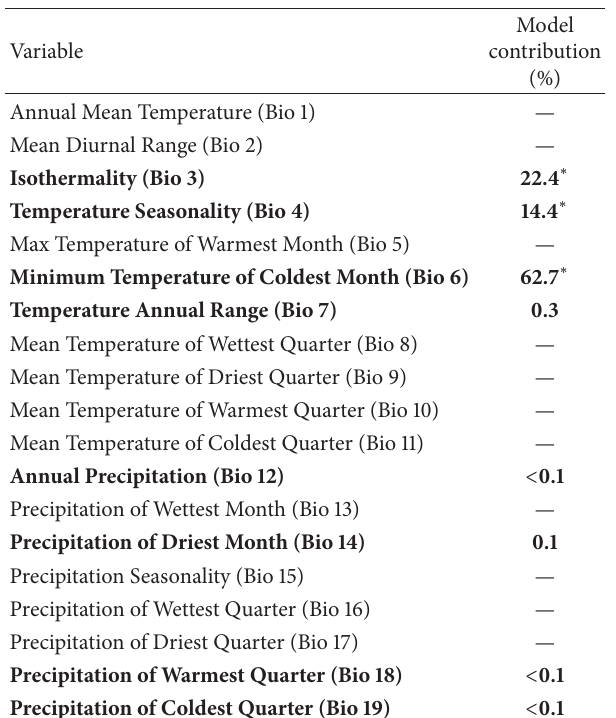
Table 1: Bioclimatic variables from WorldClim database. The variables in bold type were chosen to model the distribution of P. splendens after Pearson correlation